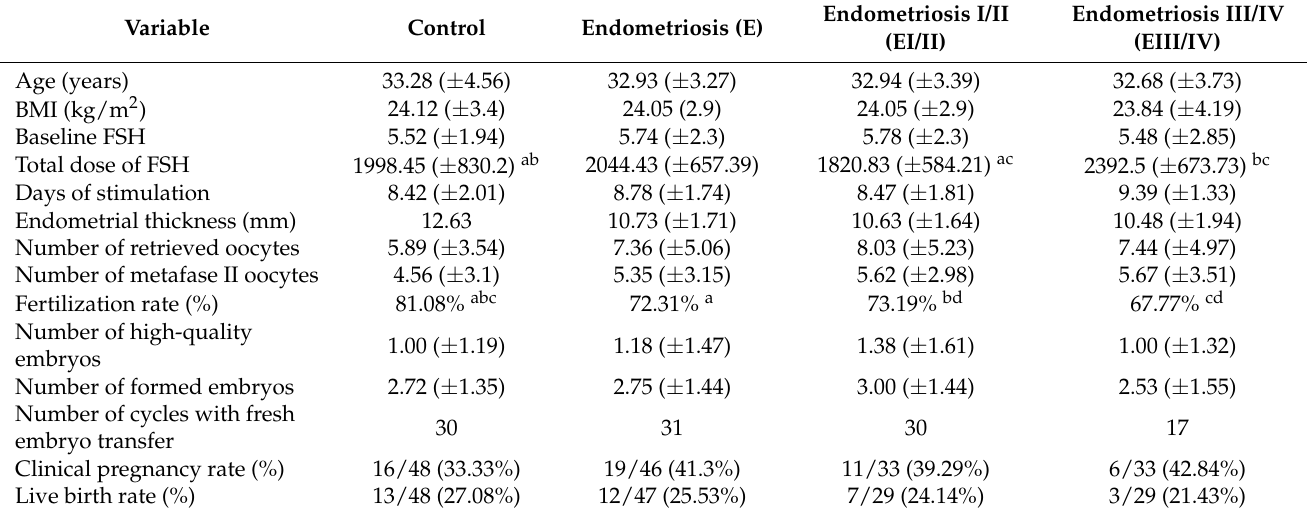
Table 1. Clinical variables, responses to ovarian stimulation, and ICSI outcomes for infertile pa- tients without endometriosis and with endometriosis, EI/II, and EIII/IV who underwent controlled ovarian